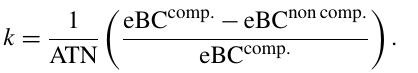
Figure 7. Shapes of sample spots observed during maintenance in group D. (a) Instrument D03; (b) instrument D01. These instru- ments used different filter tapes (D03: T60A20; D01: M8060). The spot size was not measured during the workshops. Irregular or dif- fuse edges of the filter spot can indicate